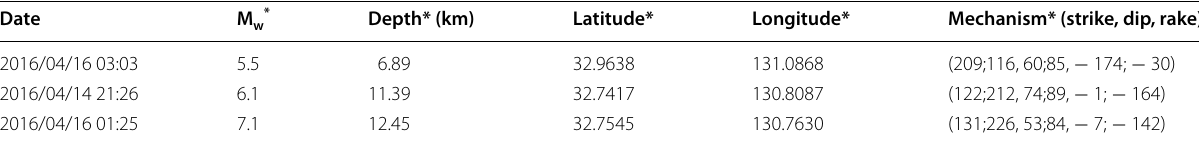
* M w and focal mechanisms were obtained from F-net, depth, latitude, and longitude from the Japan Meteorological Agency (JMA). All times and dates are presented for JST time zone